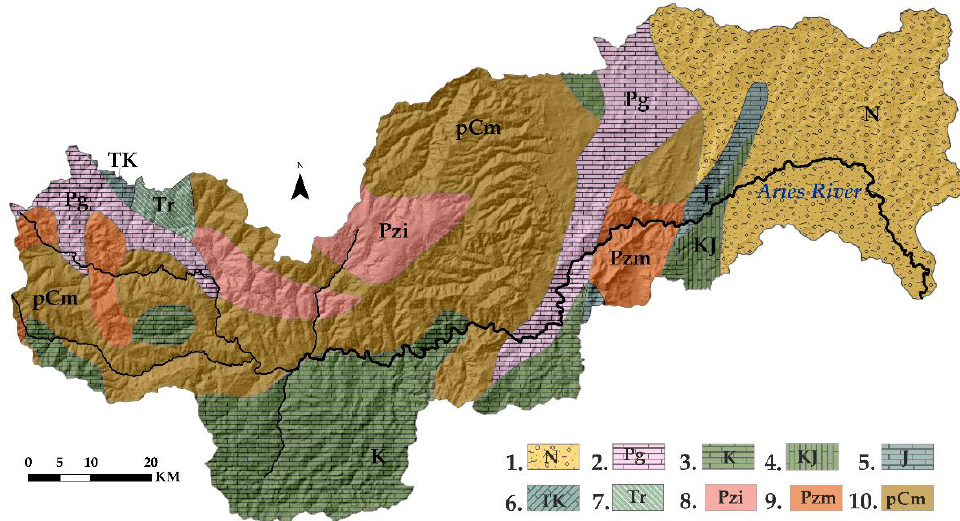
Figure 1. Geologic map of the Aries catchment (modified after Pawlewicz et al., 2002 [24] ).1. Neo-